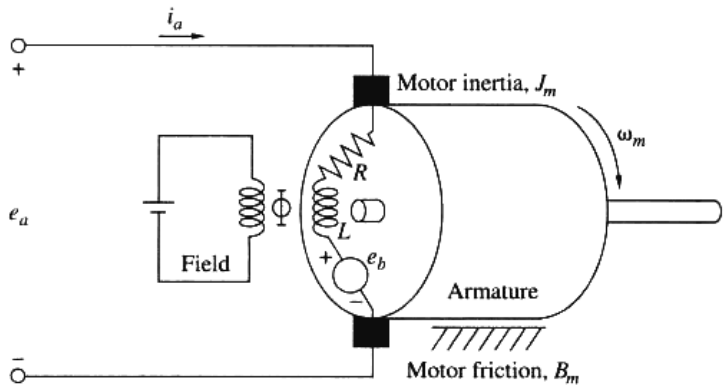
Figure 3. A schematic representation of an armature controlled DC